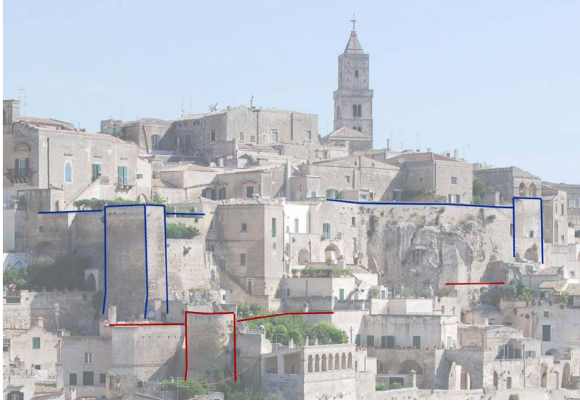
Figure 8. An info-graphics image about city walls.